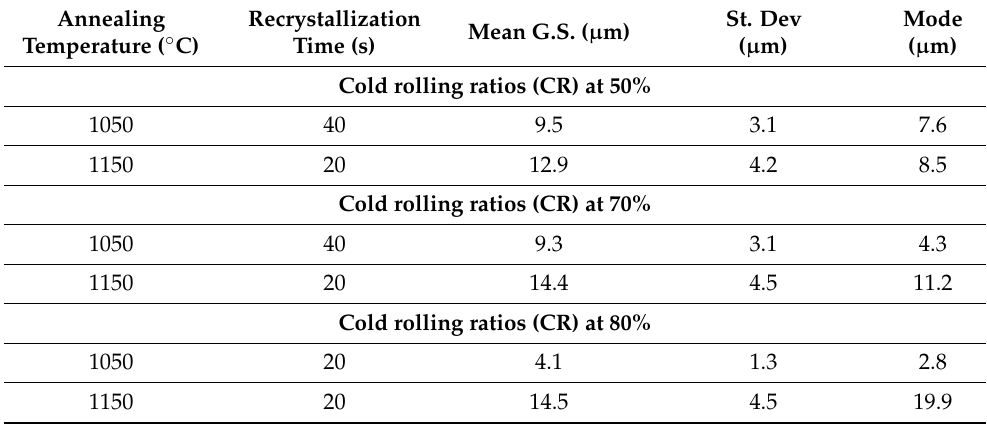
Table 3. The average grain size for the recrystallized material for different process